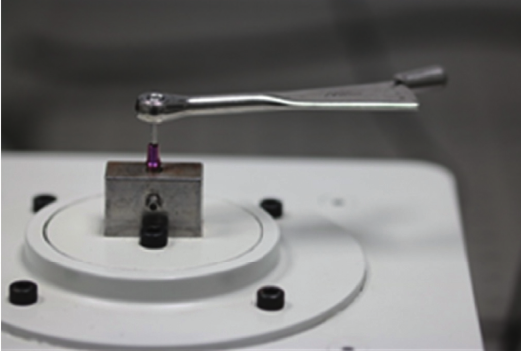
Figure 2: Representation of the torquemeter assembly.